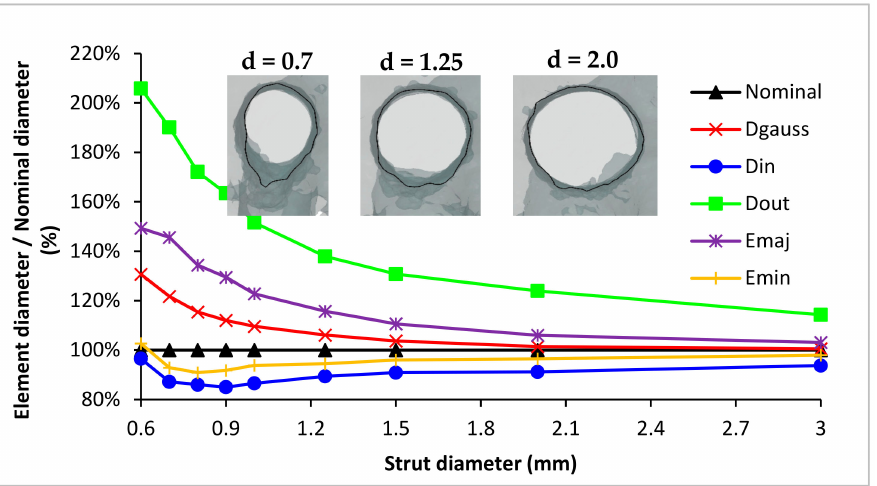
Figure 9. Graph of individual characteristic elements dimensions, relative to the nominal diameter, in relation to the nominal diameter of the